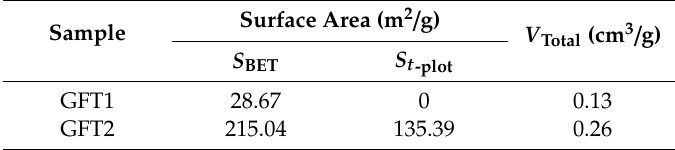
Table 1. Comparison of product properties between GFT1 and GFT2.